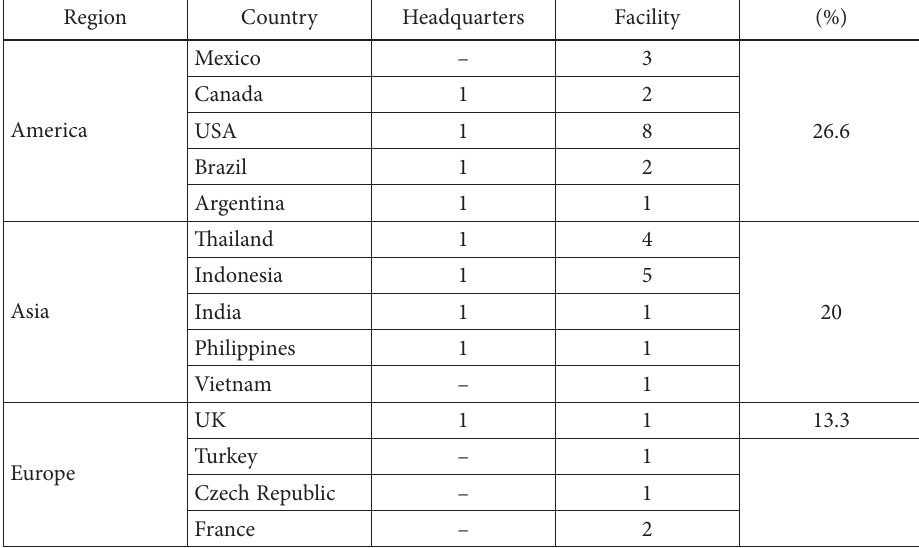
Table 3. Motor Corporation’s headquarter and assembly facility statistics (source: authors’ own study) Region Country Headquarters Facility